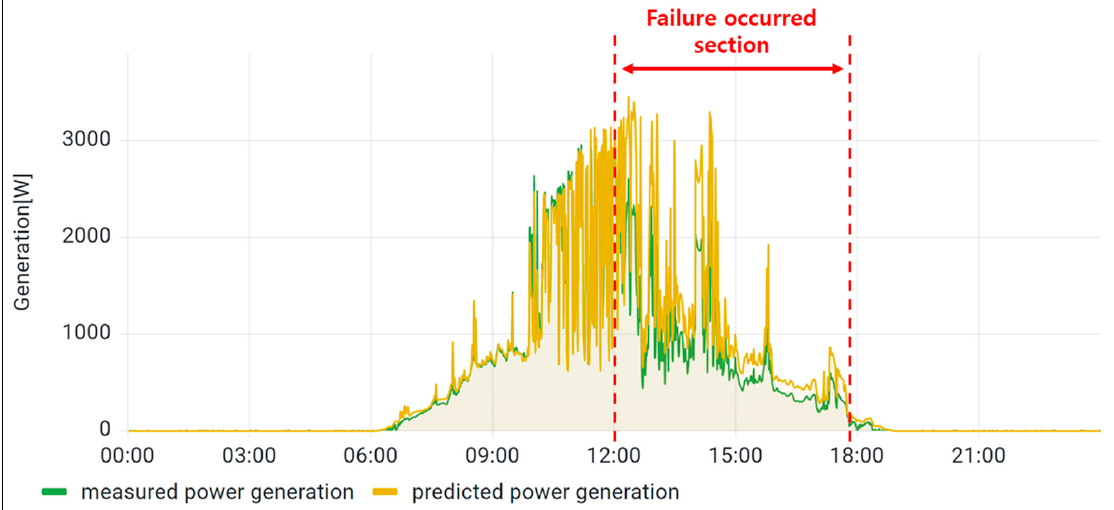
9 of 12 Figure 7. Predicted and measured power generation in normal operation. Figure 8. PPR in normal operation. Figure 9 shows a clear deviation between the measured and predicted power genera- tion in the case of inducement of shading and disconnection. Energy loss during power gen-